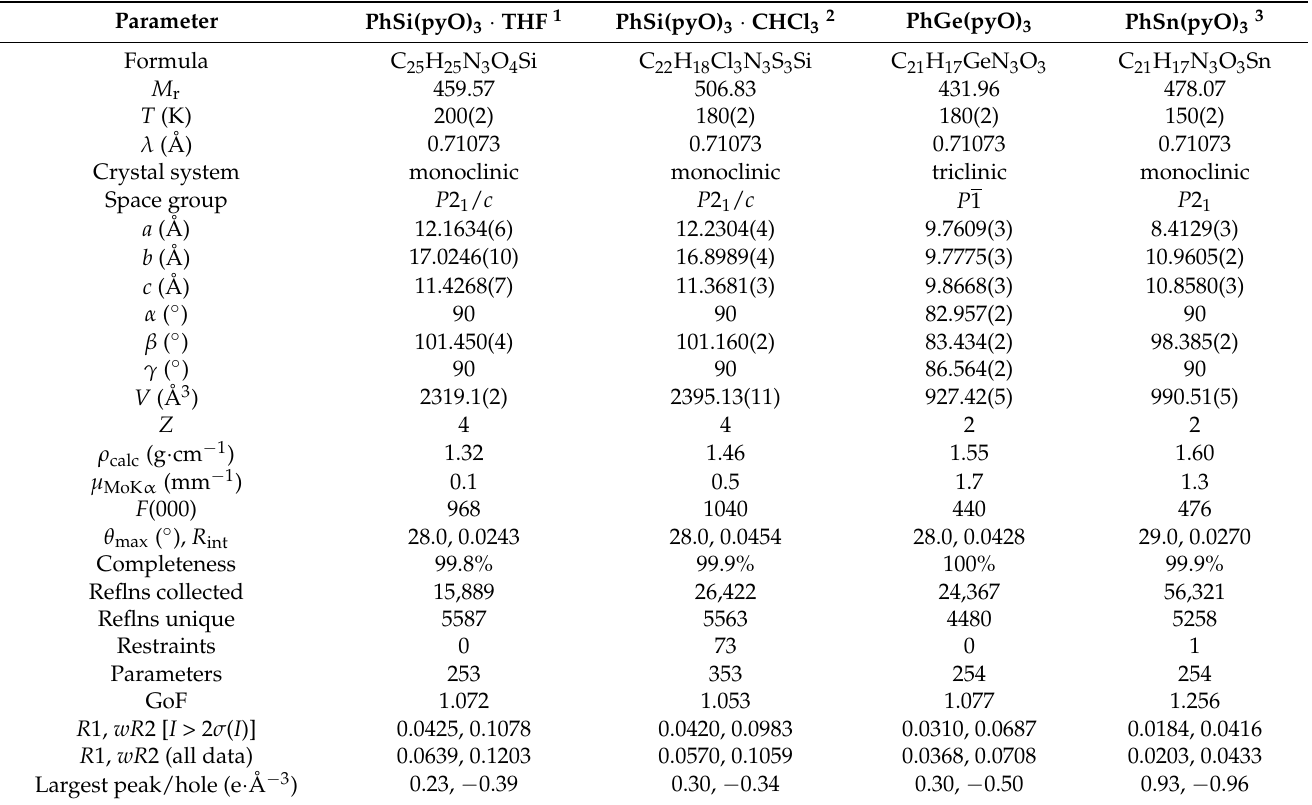
Table A1. Crystallographic data from data collection and refinement for PhSi(pyO) 3 (its THF solvate, and chloroform solvate), PhGe(pyO) 3 , and PhSn(pyO) 3